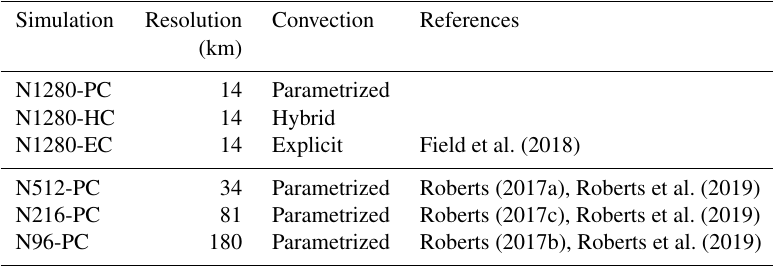
Table 1. List of simulations. All the simulations were performed with the UM. The JJA seasons from 2005 to 2008 are used. The resolution is denoted by the equivalent longitudinal length of the grid cells at 30 ◦ N. Our focus is on the two high-resolution simulations N1280-PC and N1280-EC, although we compare with N1280-HC and the coarser simulations. All the simulation settings are described in the main